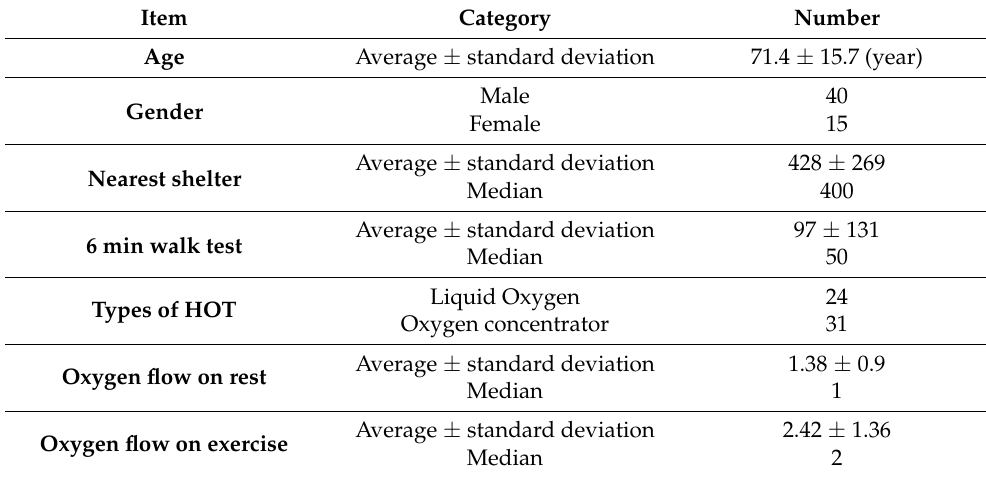
Table 1. The characteristics of patients ( n =